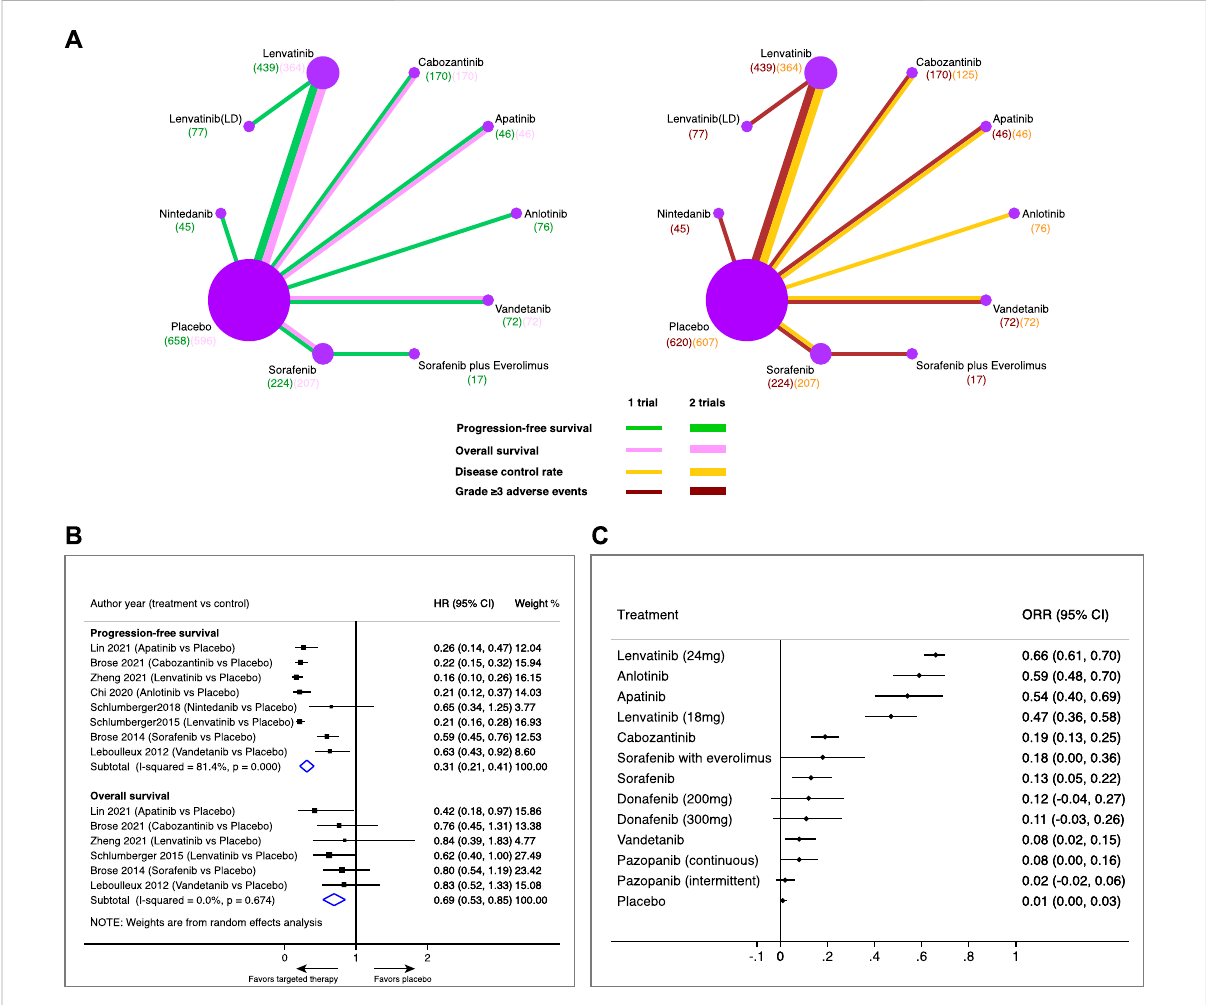
FIGURE 2 Pairwise meta-analysis of a comparison of targeted therapy versus placebo on major outcomes in patients with radioiodine-refractory differentiated thyroid cancer. (A) Network diagrams of comparing progression-free survival (PFS), overall survival (OS), disease control rate (DCR), and grade 3 or higher adverse events ( P 3 AEs). Each circular node represents a type of treatment. Each line represents a type of head-to-head comparison. Node size and line thickness are weighted according to the number of studies evaluating each treatment and direct comparison, respectively. The total number of patients receiving a treatment is shown in brackets. (B) Pooled hazard ratio (HR) of PFS and OS in comparison of targeted therapy versus placebo. (C) Objective response rate (ORR) and its 95% con fi dence interval (CI) for each